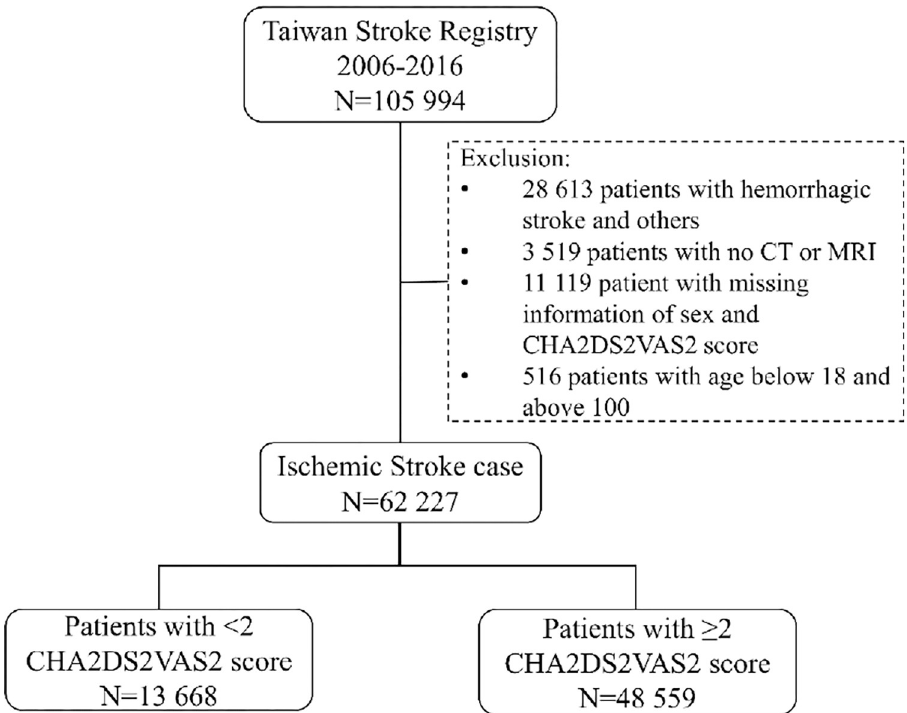
Fig 1. Patient flow in the study comparing high and low CHA2DS2-VASc